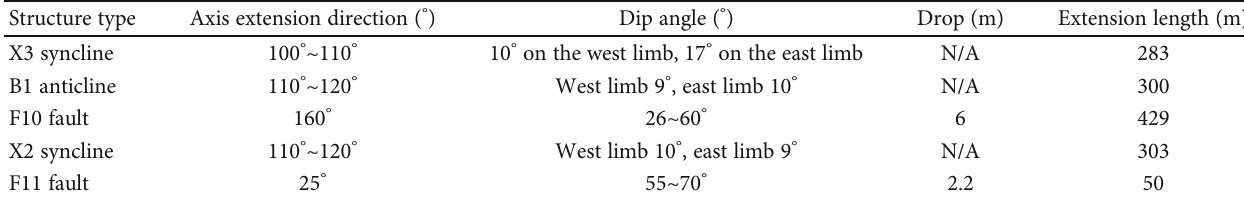
Table 3: Main parameters of the geological structure of the 1302 coal mining working face.